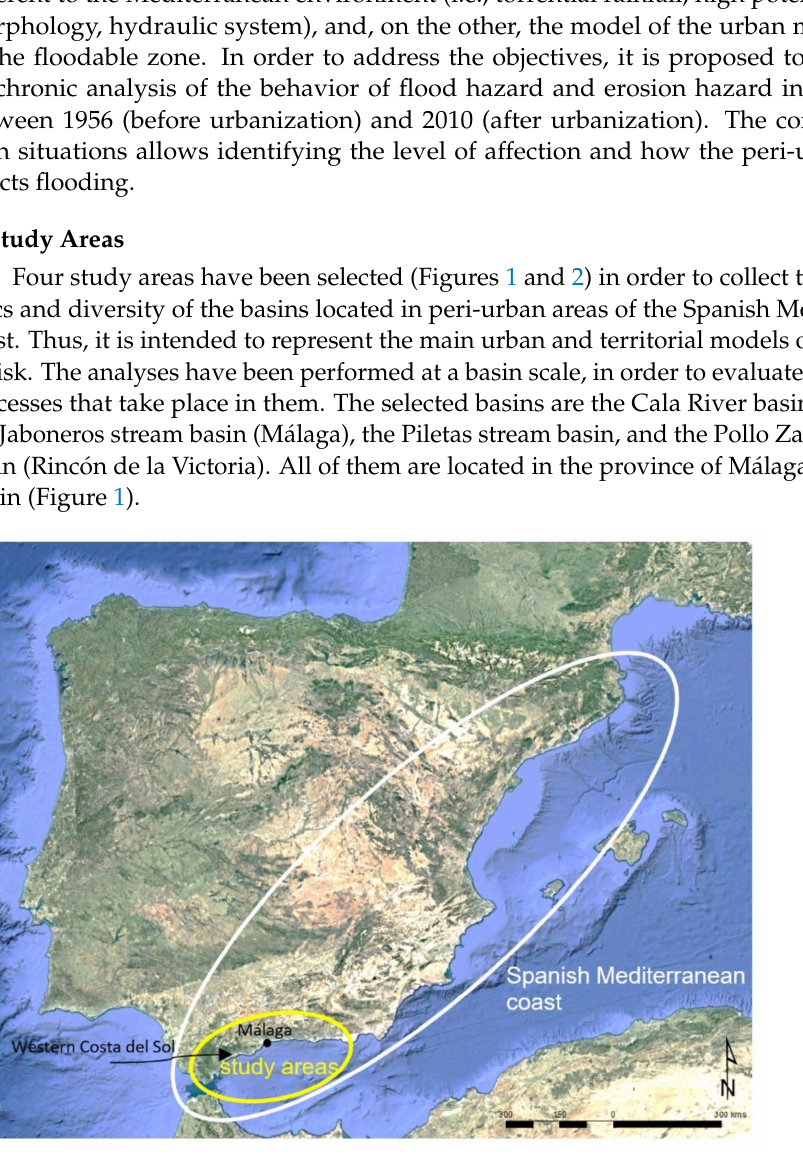
Figure 1. Location of the study areas in the Spanish Mediterranean